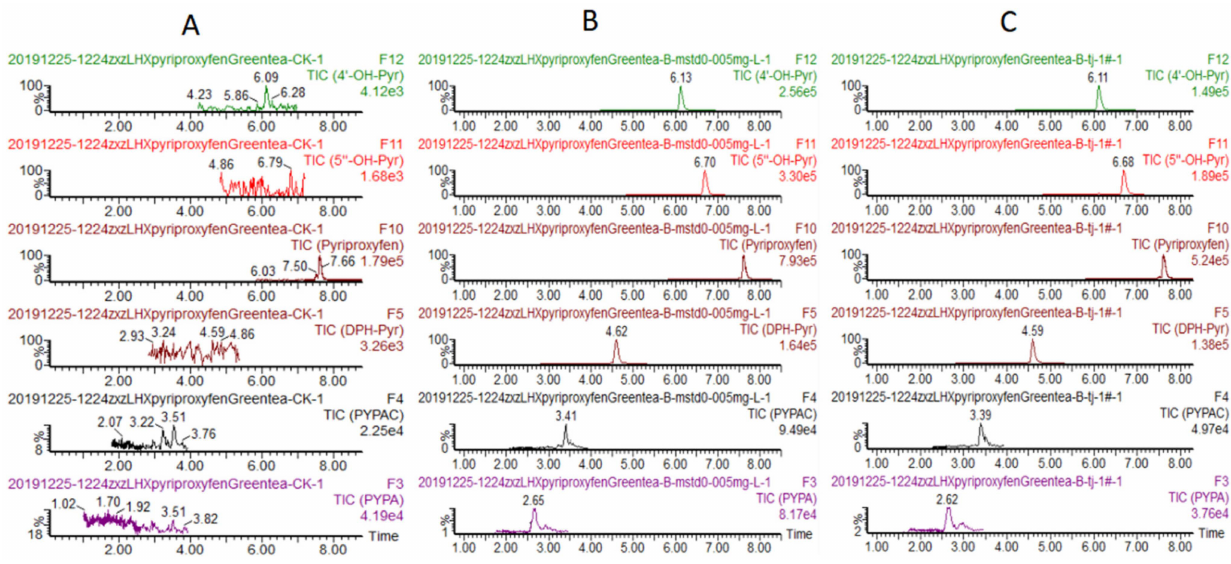
Figure 3. The chromatograms of pyriproxyfen and its five metabolites in blank green tea ( A ), matrix standard at 0.005 mg/L ( B ) and the 0.025 mg/kg-spiked level ( C ). Defined as the lowest spike concentrations with suitable recoveries and RSDs, the LOQ of pyriproxyfen and its metabolites in fresh tea leaves was 0.002 mg/kg; in green tea and black tea, it was 0.005 mg/kg; in green-tea infusion and black-tea infusion, it was 0.0002 mg/L, respectively. As shown in Table 3, the LOQs found in this study were better 15 mg/kg of pyriproxyfen in tea in the EU, the USA and Japan